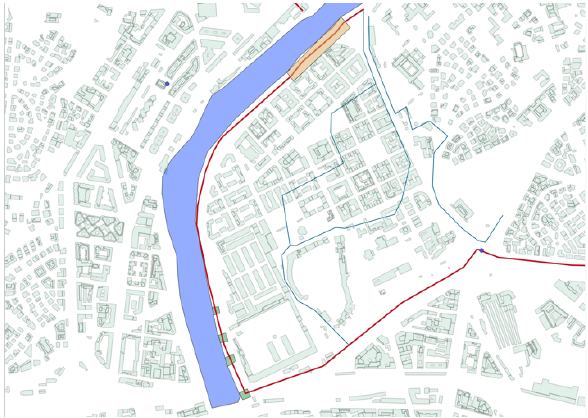
Figure 11. Detailed zoom on the WIP GIS map of the Testaccio area. Overlap with the ctr 1: 5000. In red the layout of the Aurelian Walls, in ocher the spatial encumbrance of the Emporium , in blue the now disappeared layout of the secondary city walls, in green, 4 of the turrets identified by cartographic and archival research.